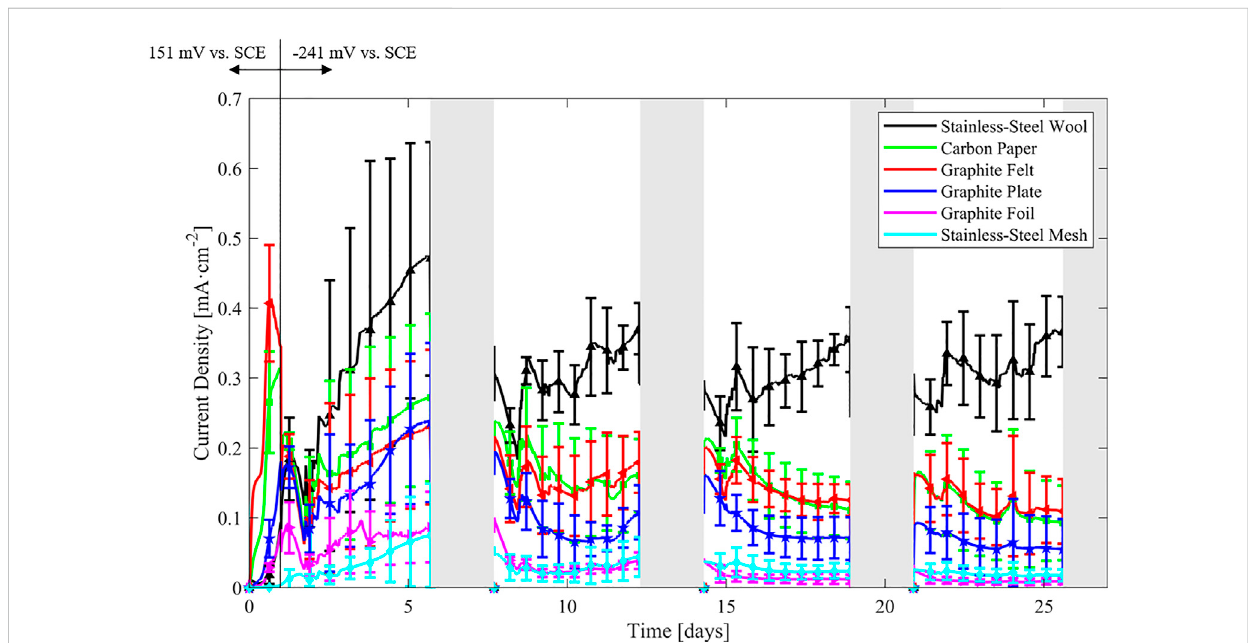
Current densities during chronoamperometric operation obtained in independent quadruplicate experiments. On the fi rst day, the electrodes were polarized at 151 mV vs. SCE and − 241 mV vs. SCE on the following days. Shaded regions indicate the interruptions for polarization